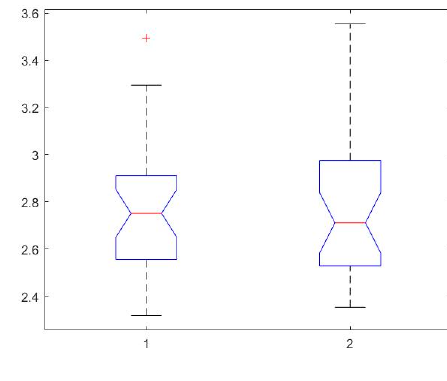
Figure 6. ANOVA test, MAPE